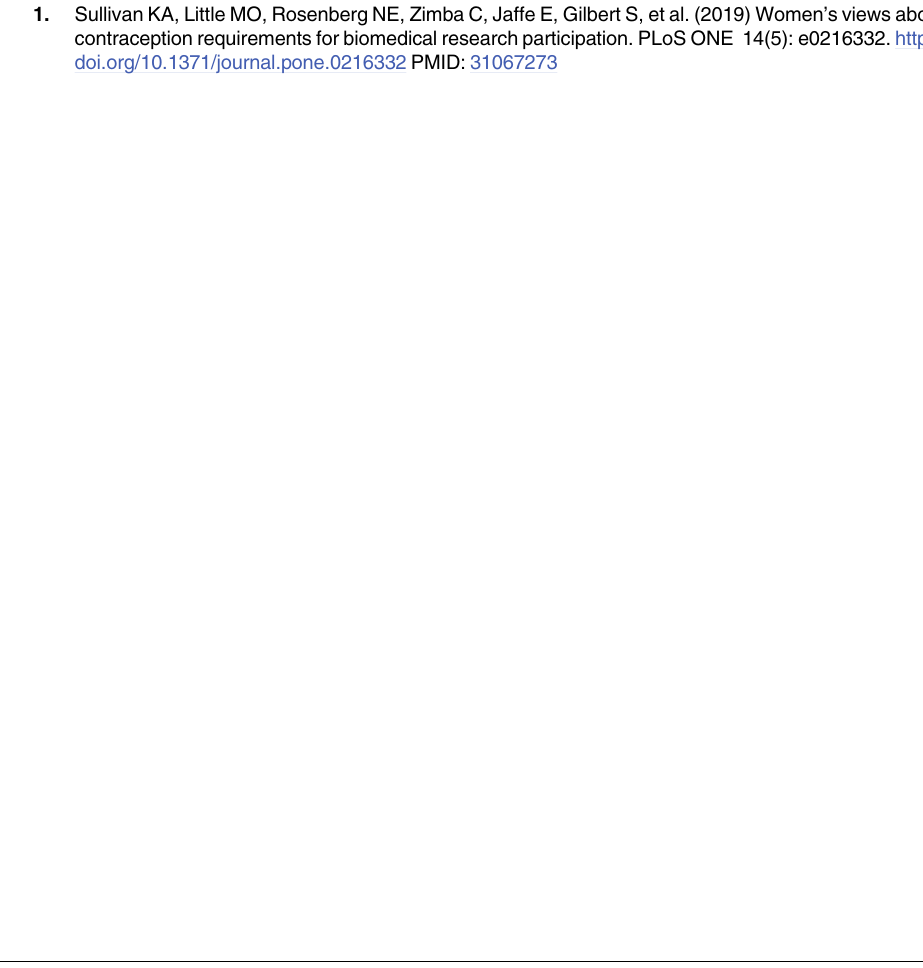
S1 File. Corrected Table 3. Themes emergent across participants’ assessments of